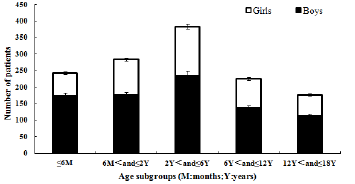
Figure 1. Analysis of the number of patients in and gender ratio of each age subgroup. M=months, Y=years.